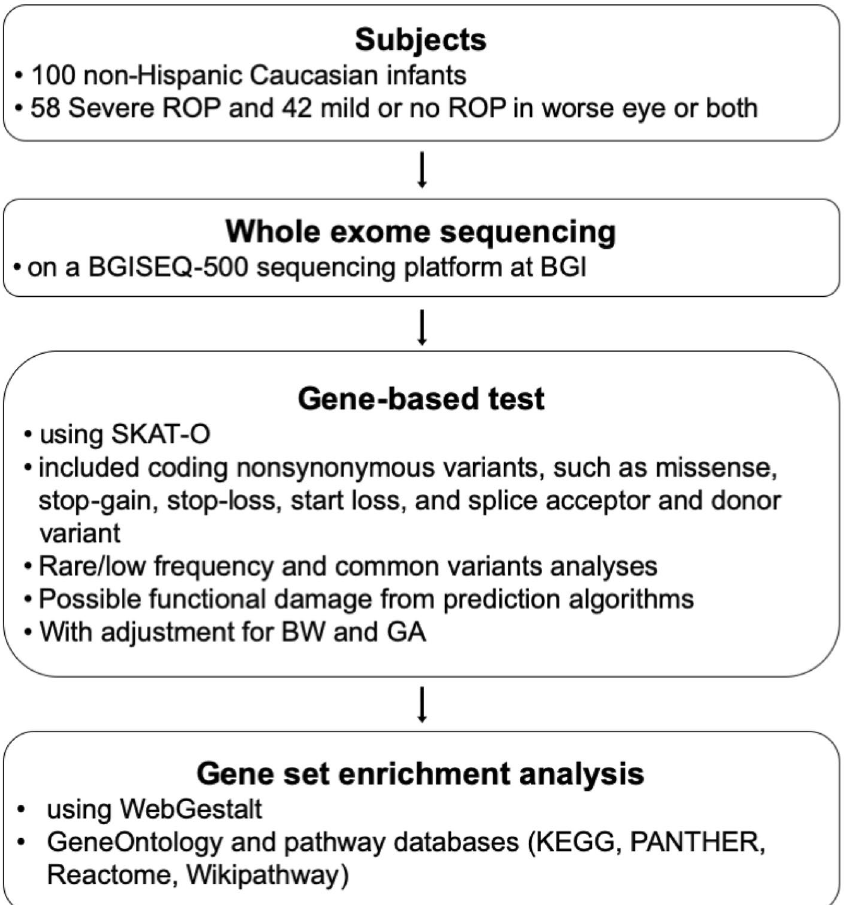
Figure 1. The overall scheme of this study. ROP retinopathy of prematurity, SKAT-O sequence kernel association optimal unified test, BW birth weight, GA gestational age, KEGG Kyoto Encyclopedia of Genes and Genomes, PANTHER Protein ANalysis THrough Evolutionary